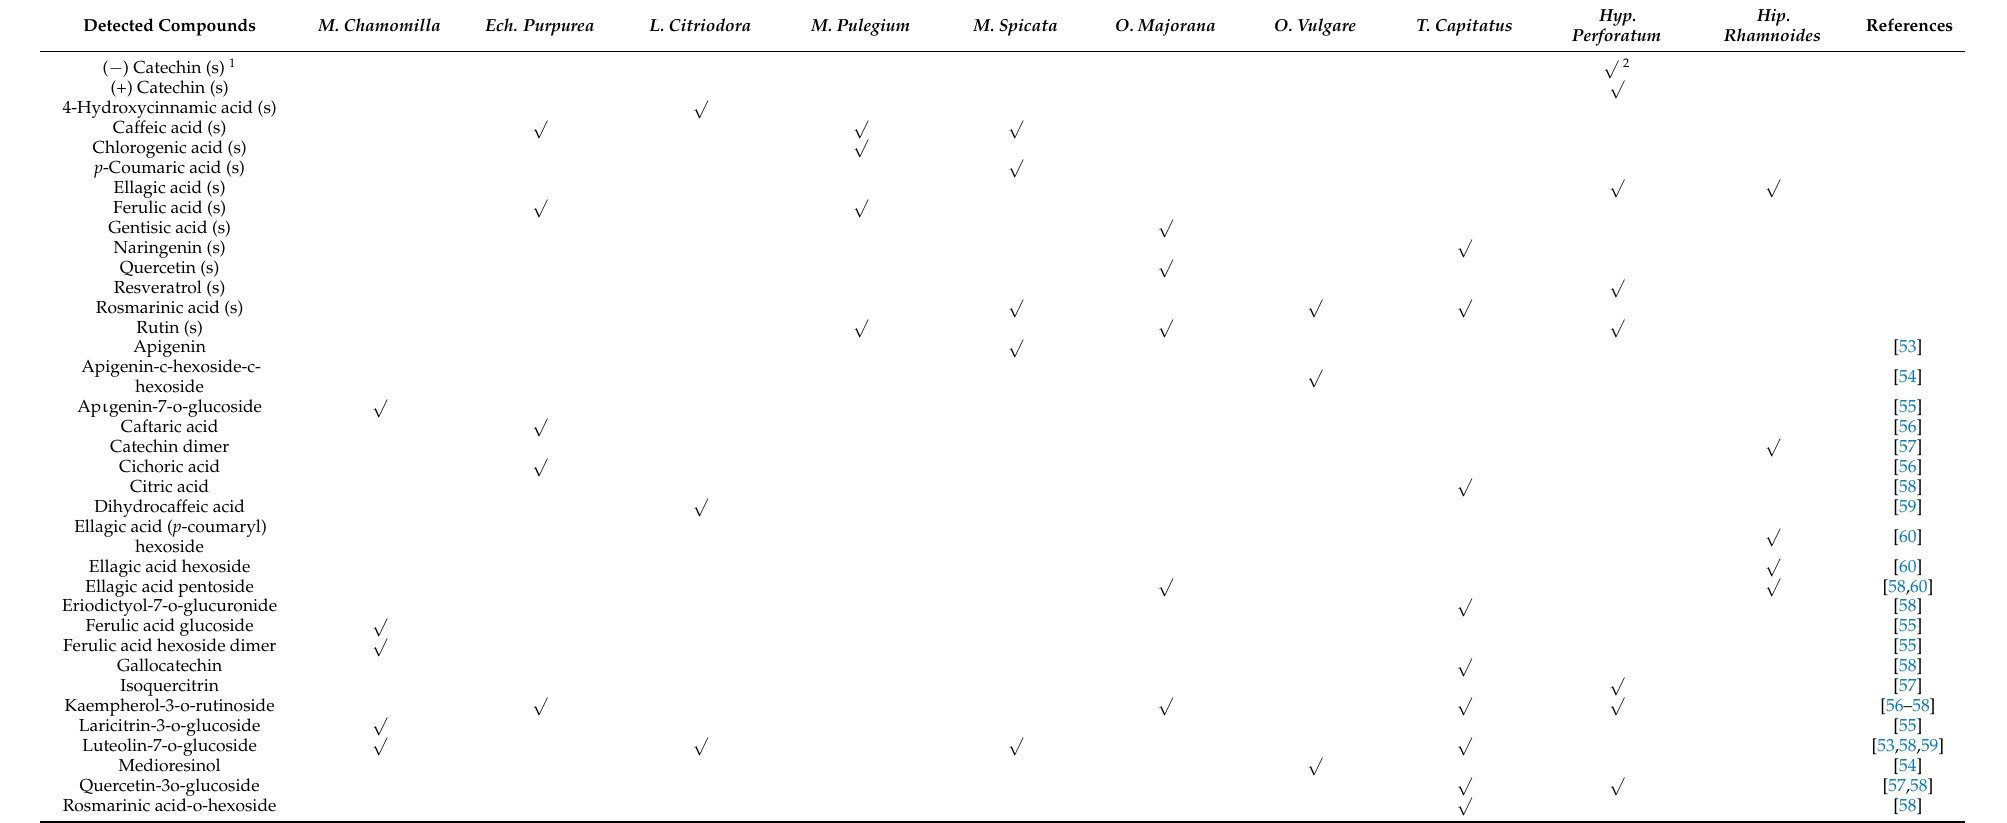
Table 2. Detected phenolic compounds in the examined herbal infusions by using the in-house phenolic compound library and literature